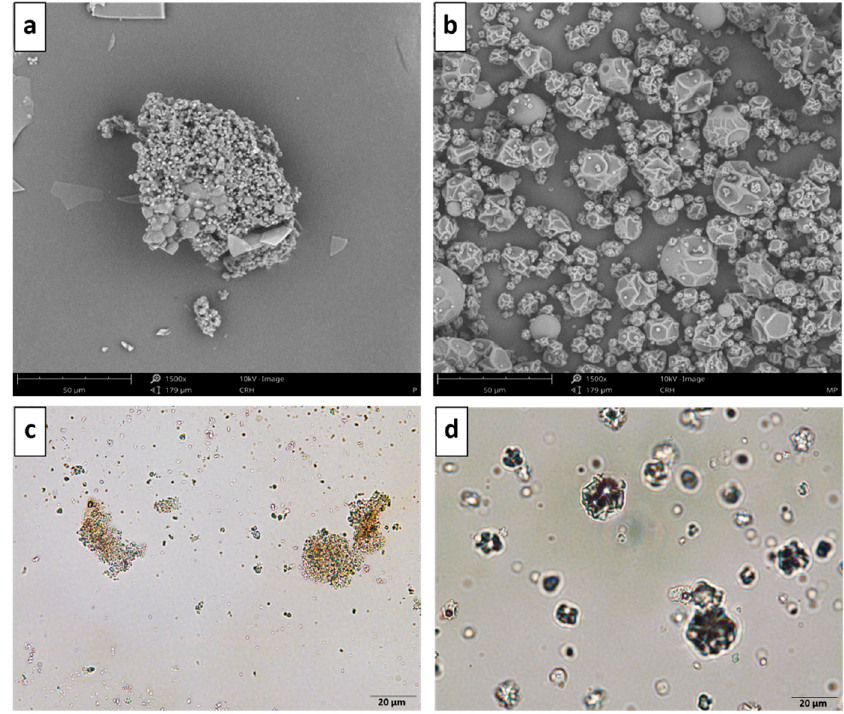
Figure 1. Images of SEM ( a , b ) and optical microscopy ( c , d ) of non-encapsulated LPBE ( a , c ) and encapsulated LPBE-MD ( b , d ) PBE. Scale bar of 50 μ m and 20 μ m applies to SEM and optical images, respectively.